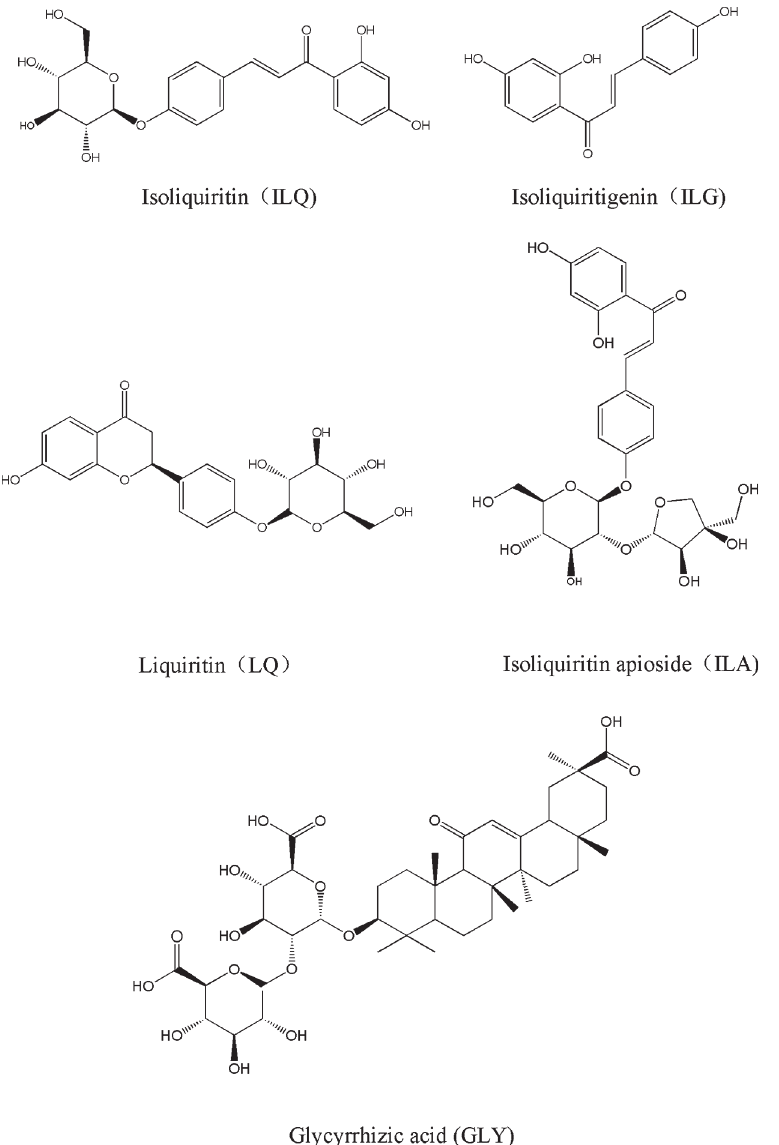
Fig 1. The molecular structures of the 5 marker